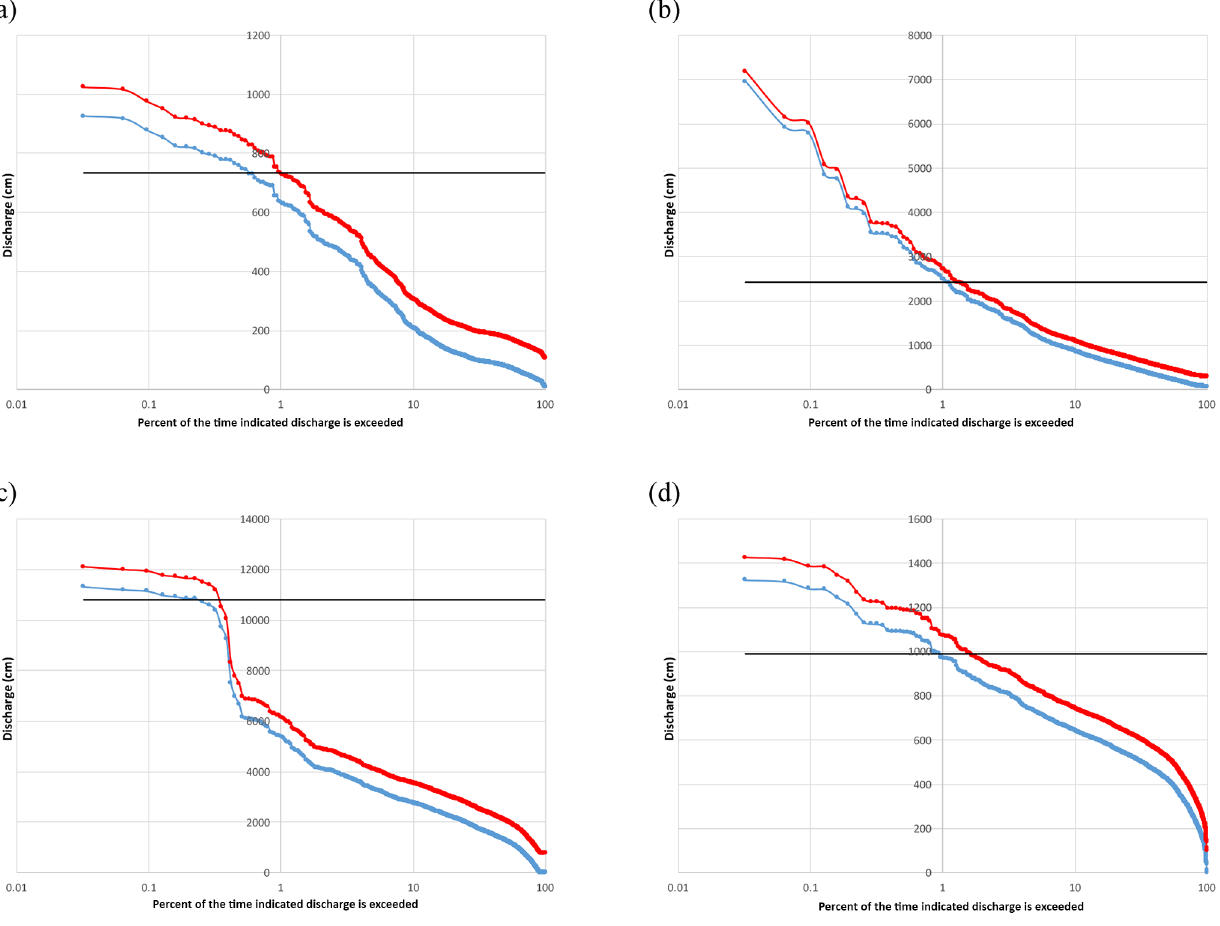
Figure 4. Bankfull discharge (black lines), flow duration curves (blue curves), and flow duration curves with discharge increased due to the average tropical cyclone (red curves) for the current hurricane season on the Neches (a) , Pearl (b) , Mobile (c) , and Roanoke (d) rivers.